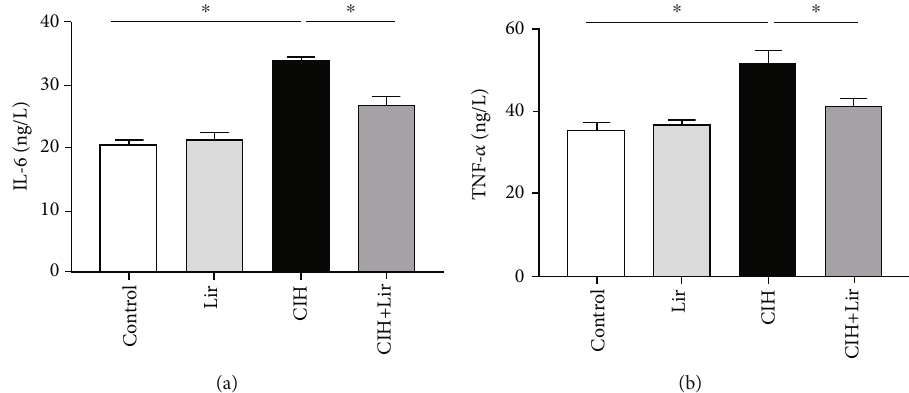
Figure 8: The e ff ect of Lir on in fl ammatory marker levels. (a, b) IL-6 and TNF- α in serum of mice detected by ELISA in four groups ( n = 6 ). Both IL-6 and TNF- α increased after CIH and decreased signi fi cantly upon Lir administration. Data are mean ± SEM , ∗ P < 0 : 05 .